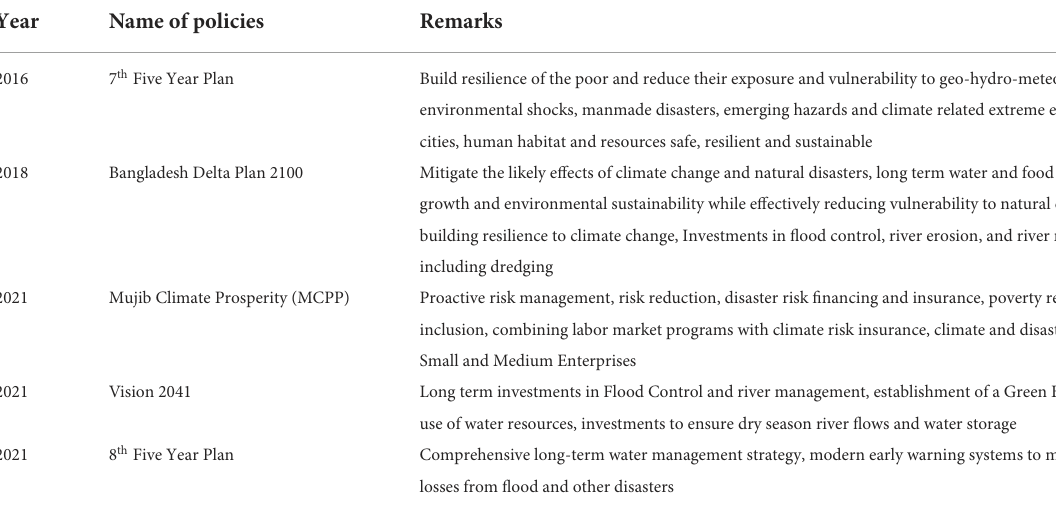
TABLE 2 Major national policy and plan for achieving prosperity under changing